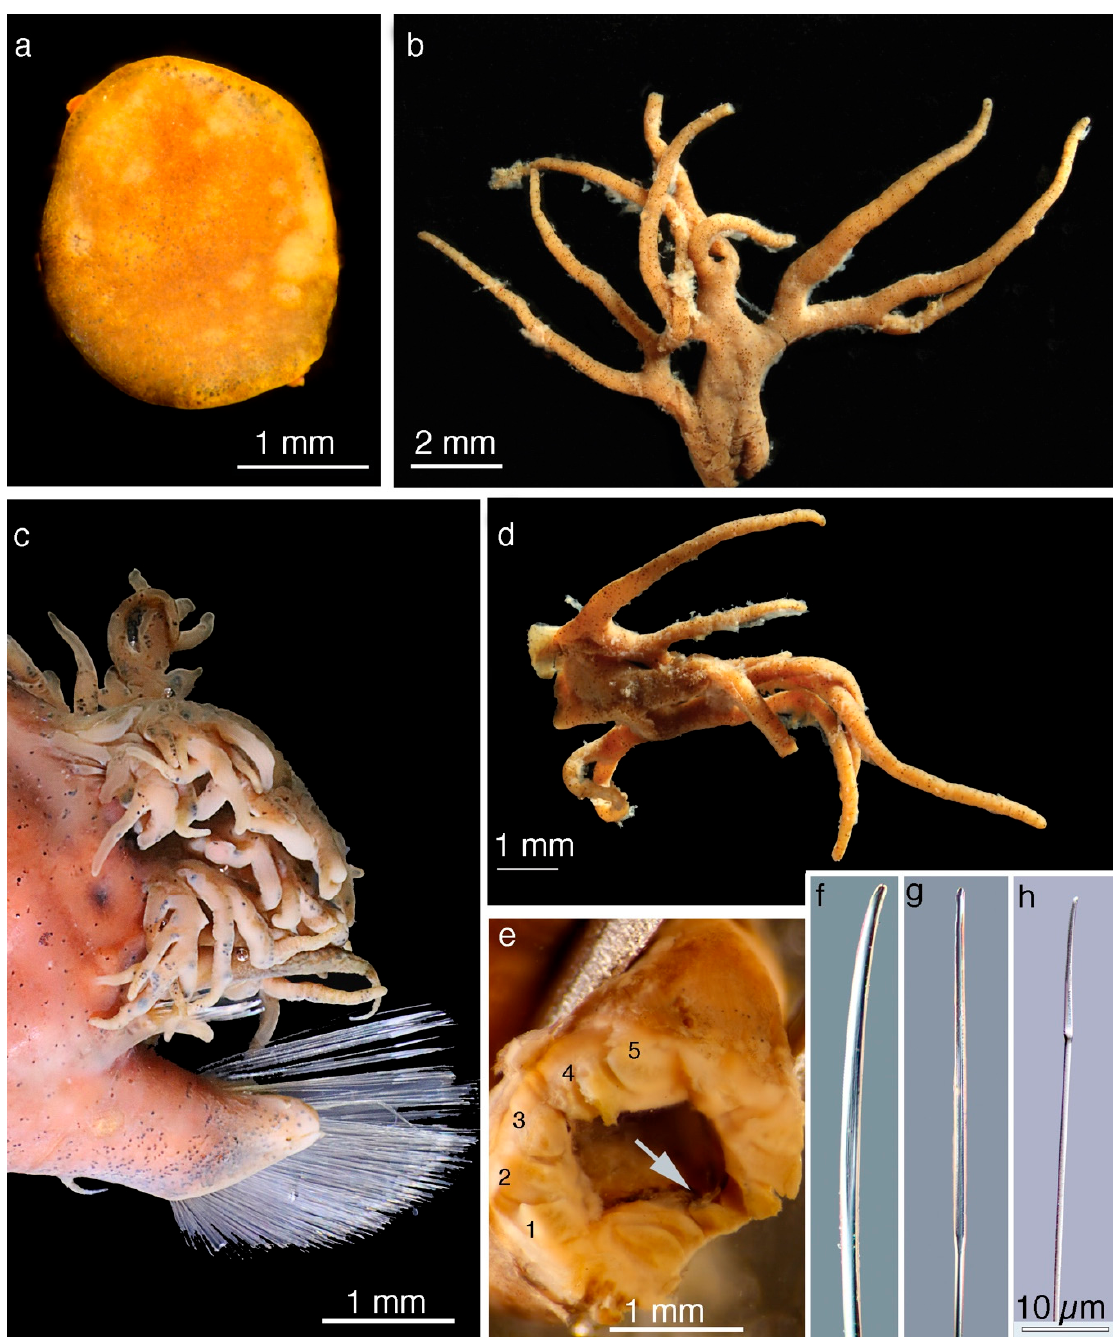
Figure 8. Branchipolynoe eliseae n. sp. paratype (MZUCR 403-01 elytron, branchiae) and holotype (SIO-BIC A6660 parapodium, chaetae): ( a ) Elytron from Segment 11. ( b ) Branchia from Segment 10 (dorsal group). ( c ) Parapodium from Segment 18 with dorsal cirrus. ( d ) Branchia from Segment 10 (ventral group). ( e ) Frontal view of proboscis showing papillae and jaws (arrow). ( f ) Notochaeta (Segment 18). ( g ) Supraacicular neurochaeta (Segment 18). ( h ) Subacicular neurochaeta (Segment 18). Same scale for ( f – h ).